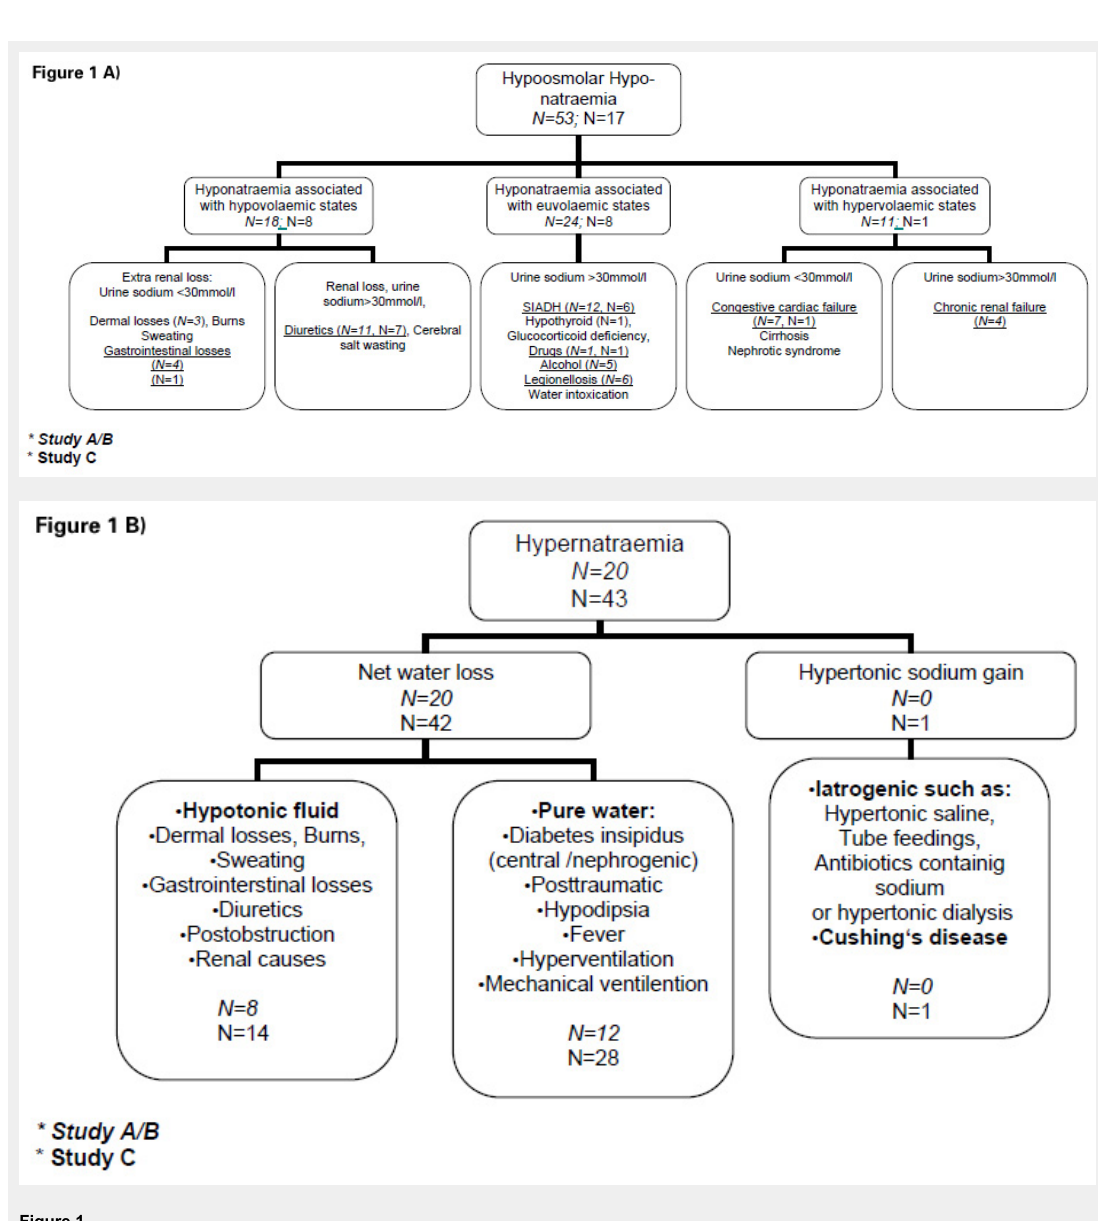
A) Flow sheet: Differential diagnosis hypoosmolar hyponatraemia B) Flow sheet: Differential diagnosis